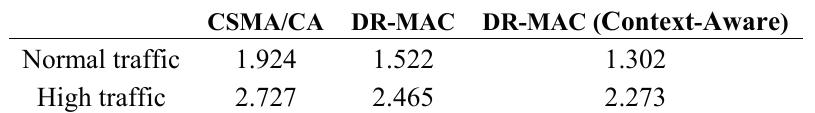
Table 3. Average number of retransmissions for a successful frame delivery.